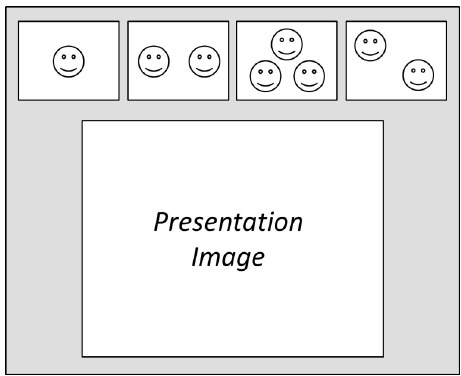
Figure 1. Screen layout for multipoint